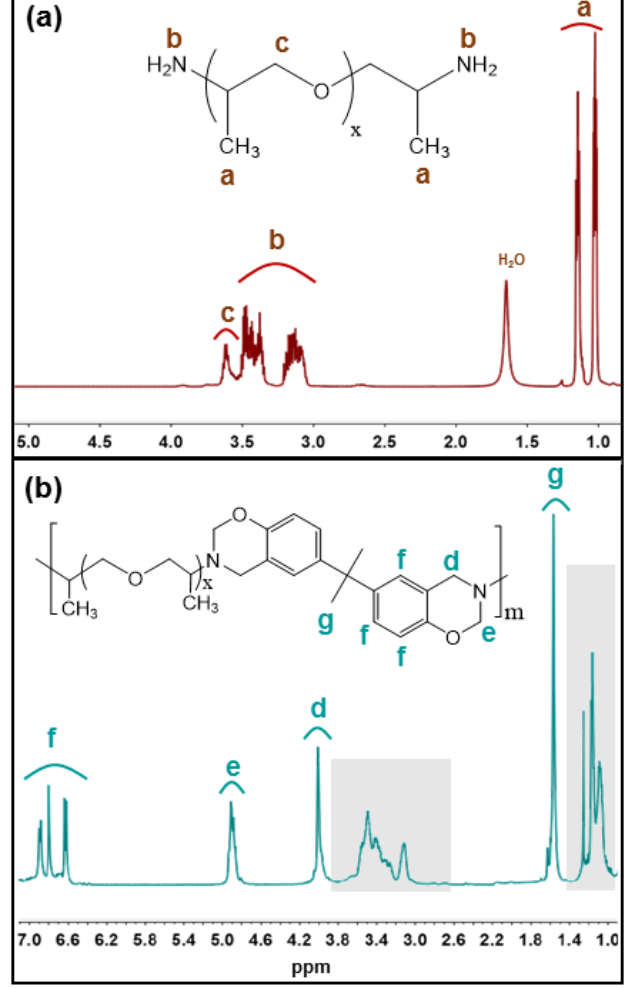
Figure 1. 1 H NMR spectra of ( a ) Jeffamine ® (JD-230) ( b ) Jeffamine ® benzoxazine polymer [Poly(BZ-JD230)].